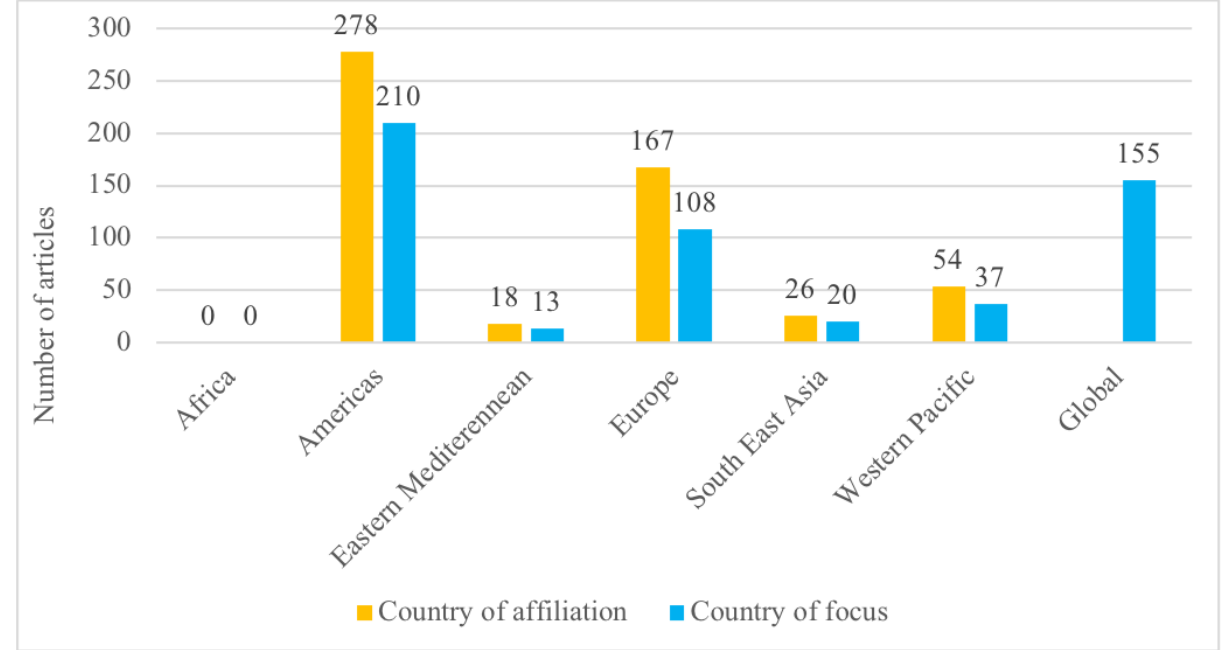
Figure 3. Number of articles based on the World Health Organization’s regional classification